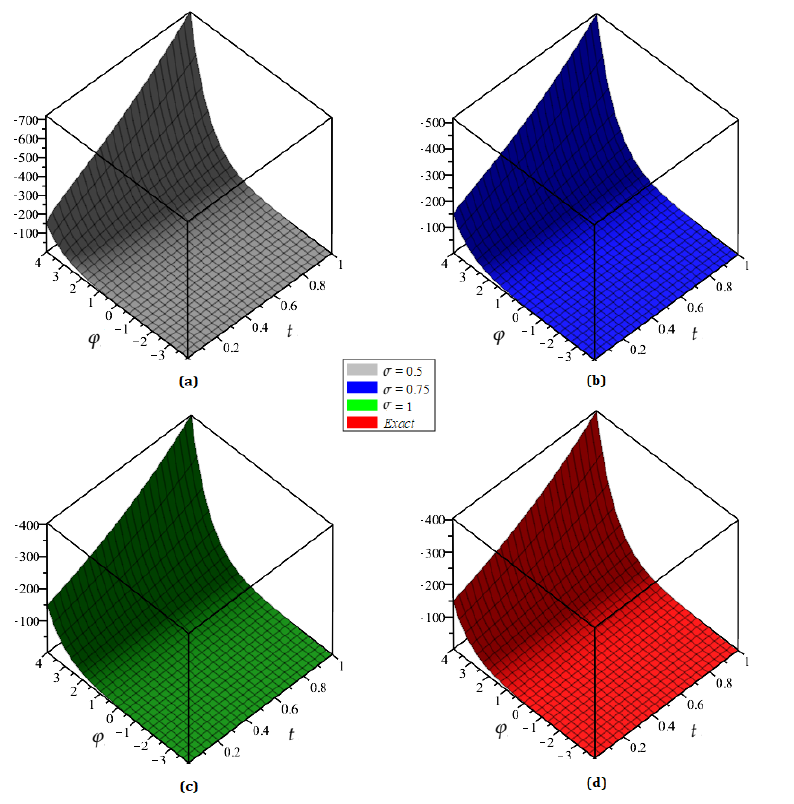
Figure 5. Three-dimensional plots of LRPSM solutions for ρ ( ϕ , ξ , t ) at distinct values of σ at ξ = 1. ( a ) σ = 0.5 ( b ) σ = 0.75 ( c ) σ = 1 ( d )